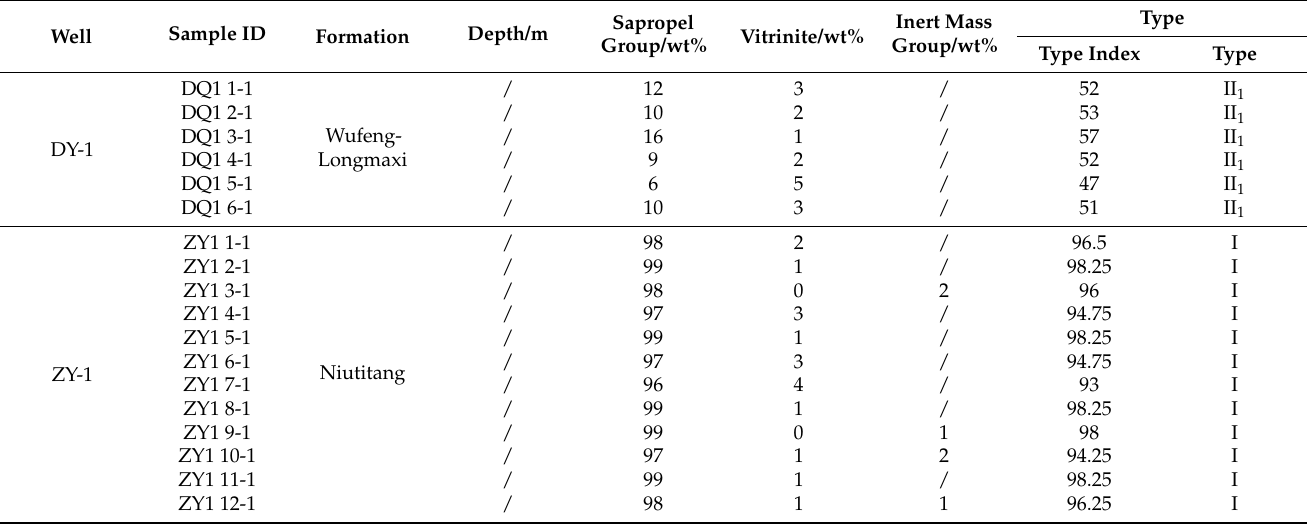
Table 2. Kerogen microscopy in the Wufeng-Longmaxi and Niutitang Formations in northern Guizhou